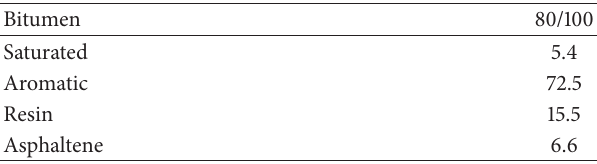
Table 2: Chemical composition of bitumen (%).